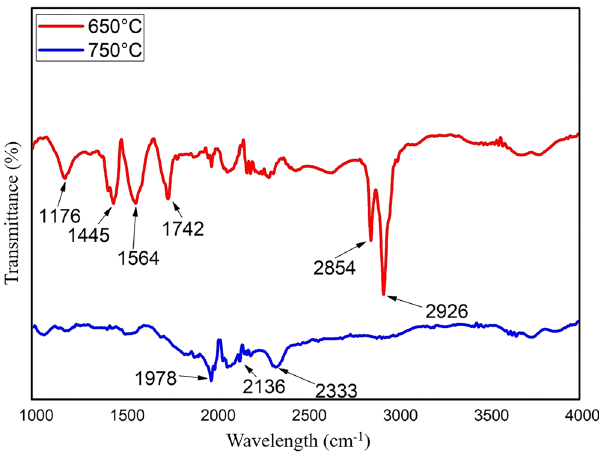
Figure 7. FTIR spectroscopy of CNM produced at 650 and 750